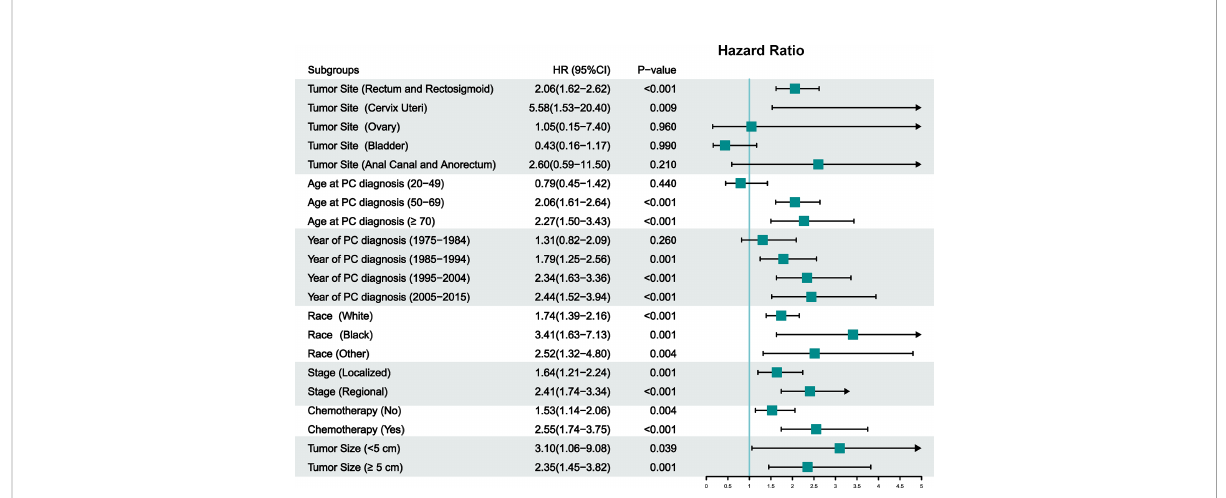
FIGURE 3 Subgroup analysis of competing risk regression analysis for the risk of developing secondary corpus uteri cancer (SCUC) in primary pelvic cancer (PPC) patients. RT, radiation therapy; NRT, no radiation therapy; PPC, primary pelvic cancers; CI, con fi dence interval; HR, hazard ratio.